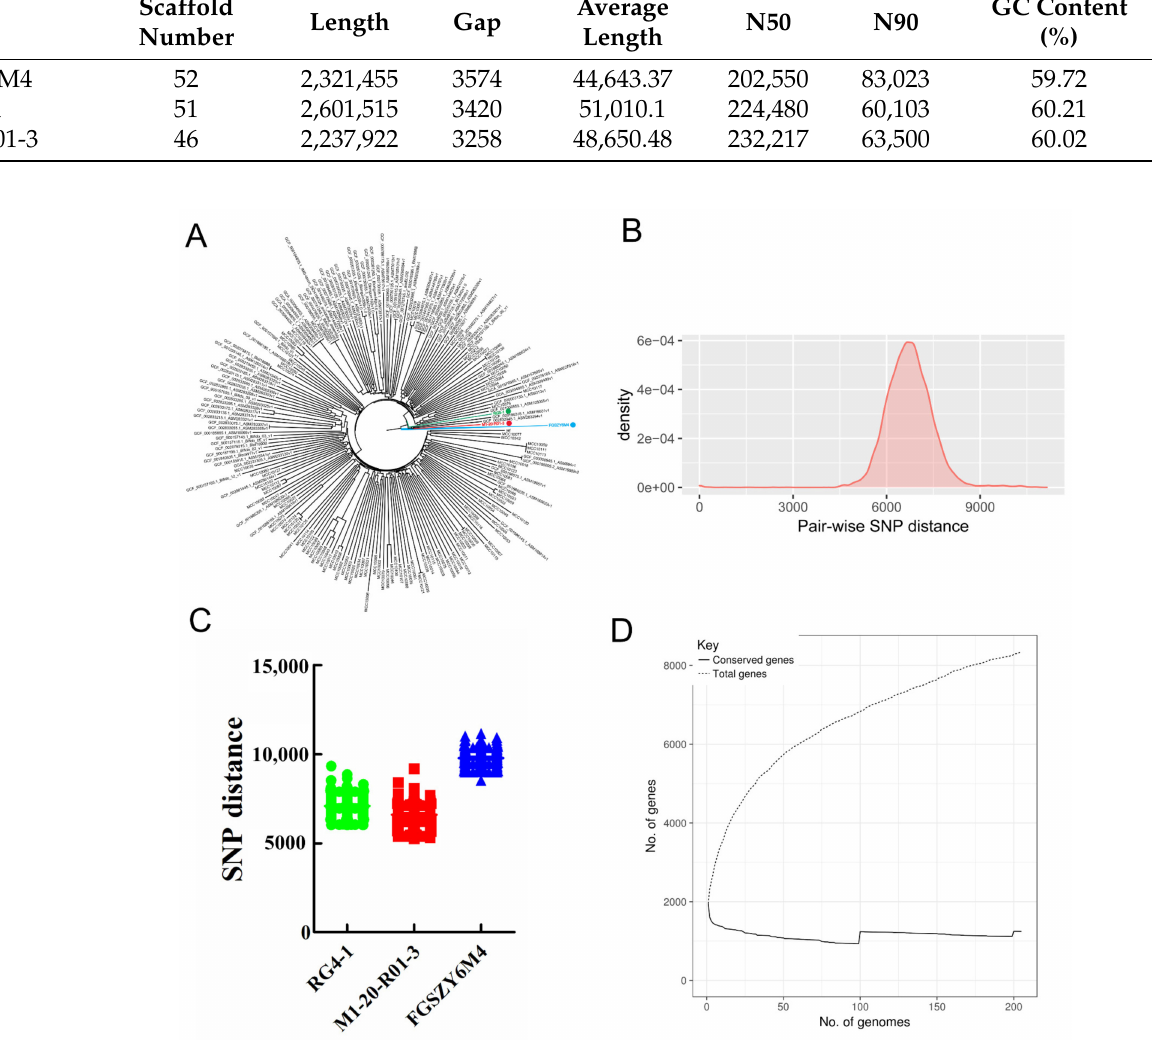
Figure 1. Phylogenetic relationship and genomic diversity of B. longum . ( A ) Phylogenetic tree (neighbor-joining method) of 205 B. longum strains. The three target strains used for strain-specific de- tection are colored. ( B ) Distribution of pair-wise SNP distances between 205 strains. ( C ) Pair-wise SNP distances between each of the target strains and all the other strains in the dataset. ( D ) Pangenome curve depicting the number of total genes detected versus the number of conserved genes as the number of included genomes